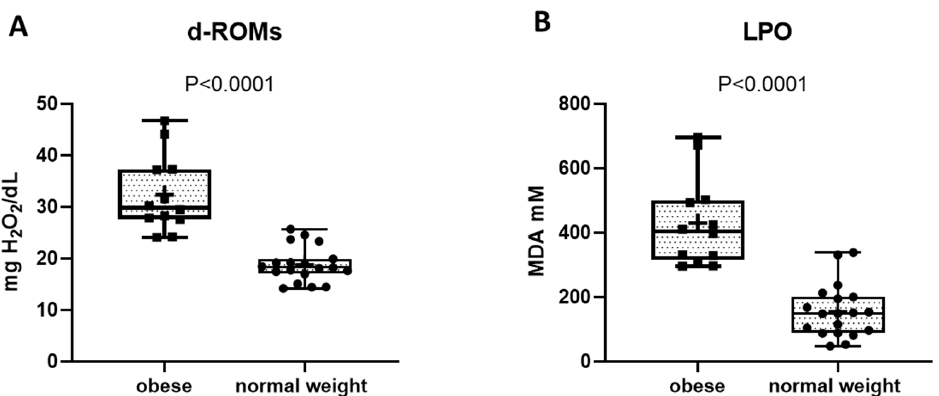
Figure 1. Oxidative stress and oxidative lipid damage in serum from study groups. ( A ) H 2 O 2 and ( B ) MDA levels were evaluated in obese and normal weight postmenopausal women. All data represent the means of at least 3 replicates ± standard deviation. The analysis of di ff erence between groups was performed using the unpaired t -test.